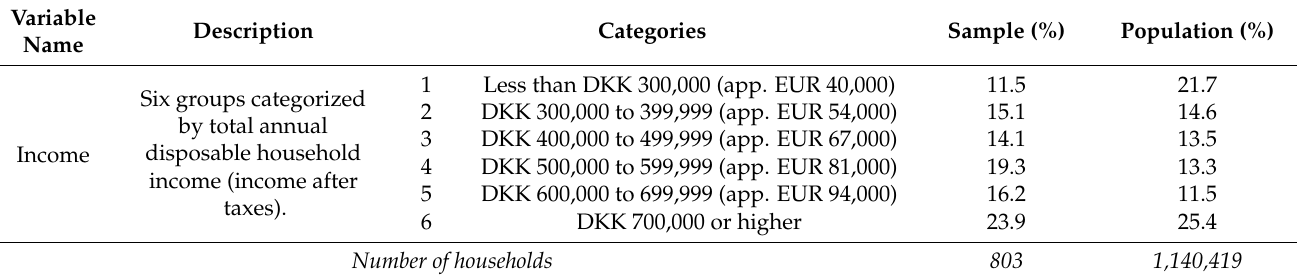
Table 3. Presentation and description of household composition variables with share (%) of the total sample. Each household can have several characteristics, so the percentages do not sum to